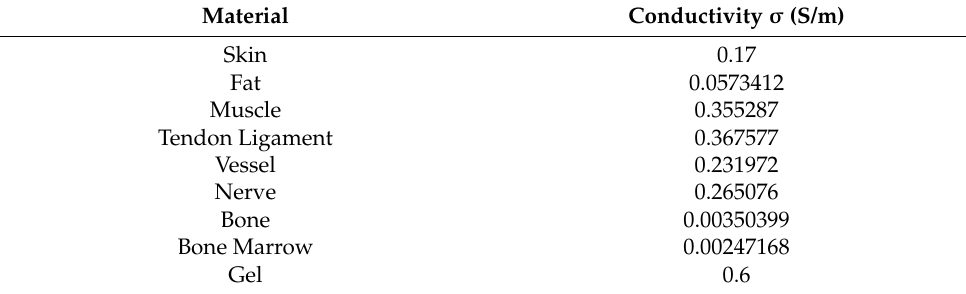
Table 2. Conductivity of each material included in the optimization.